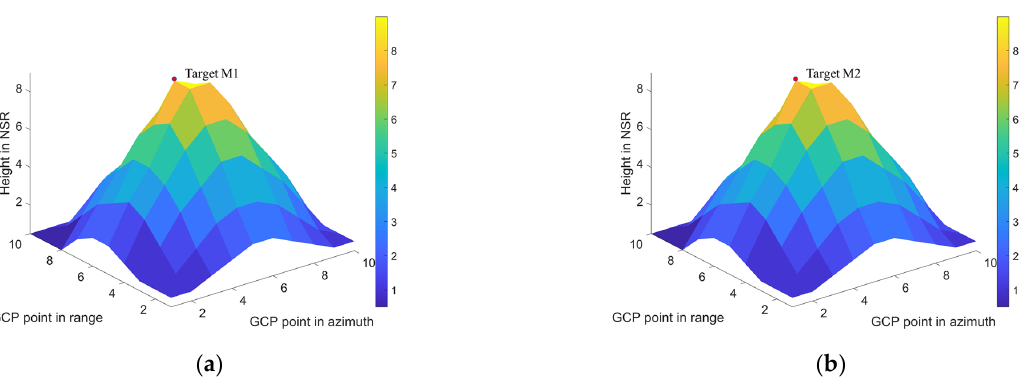
Figure 18. 3D imaging results ( v x = 0.1 m/s) in cone scene: ( a ) baseline number 20; ( b ) baseline number 10.